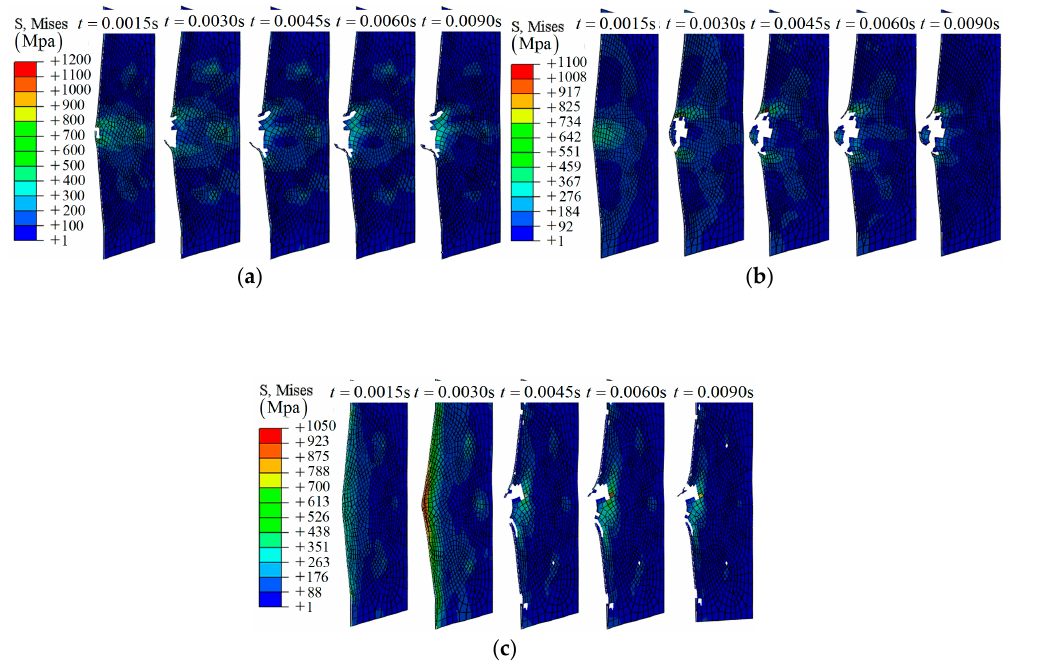
Figure 4. The middle section of different layers during the impact, group A1: ( a ) layer 16; ( b ) layer 8; ( c ) layer 1.